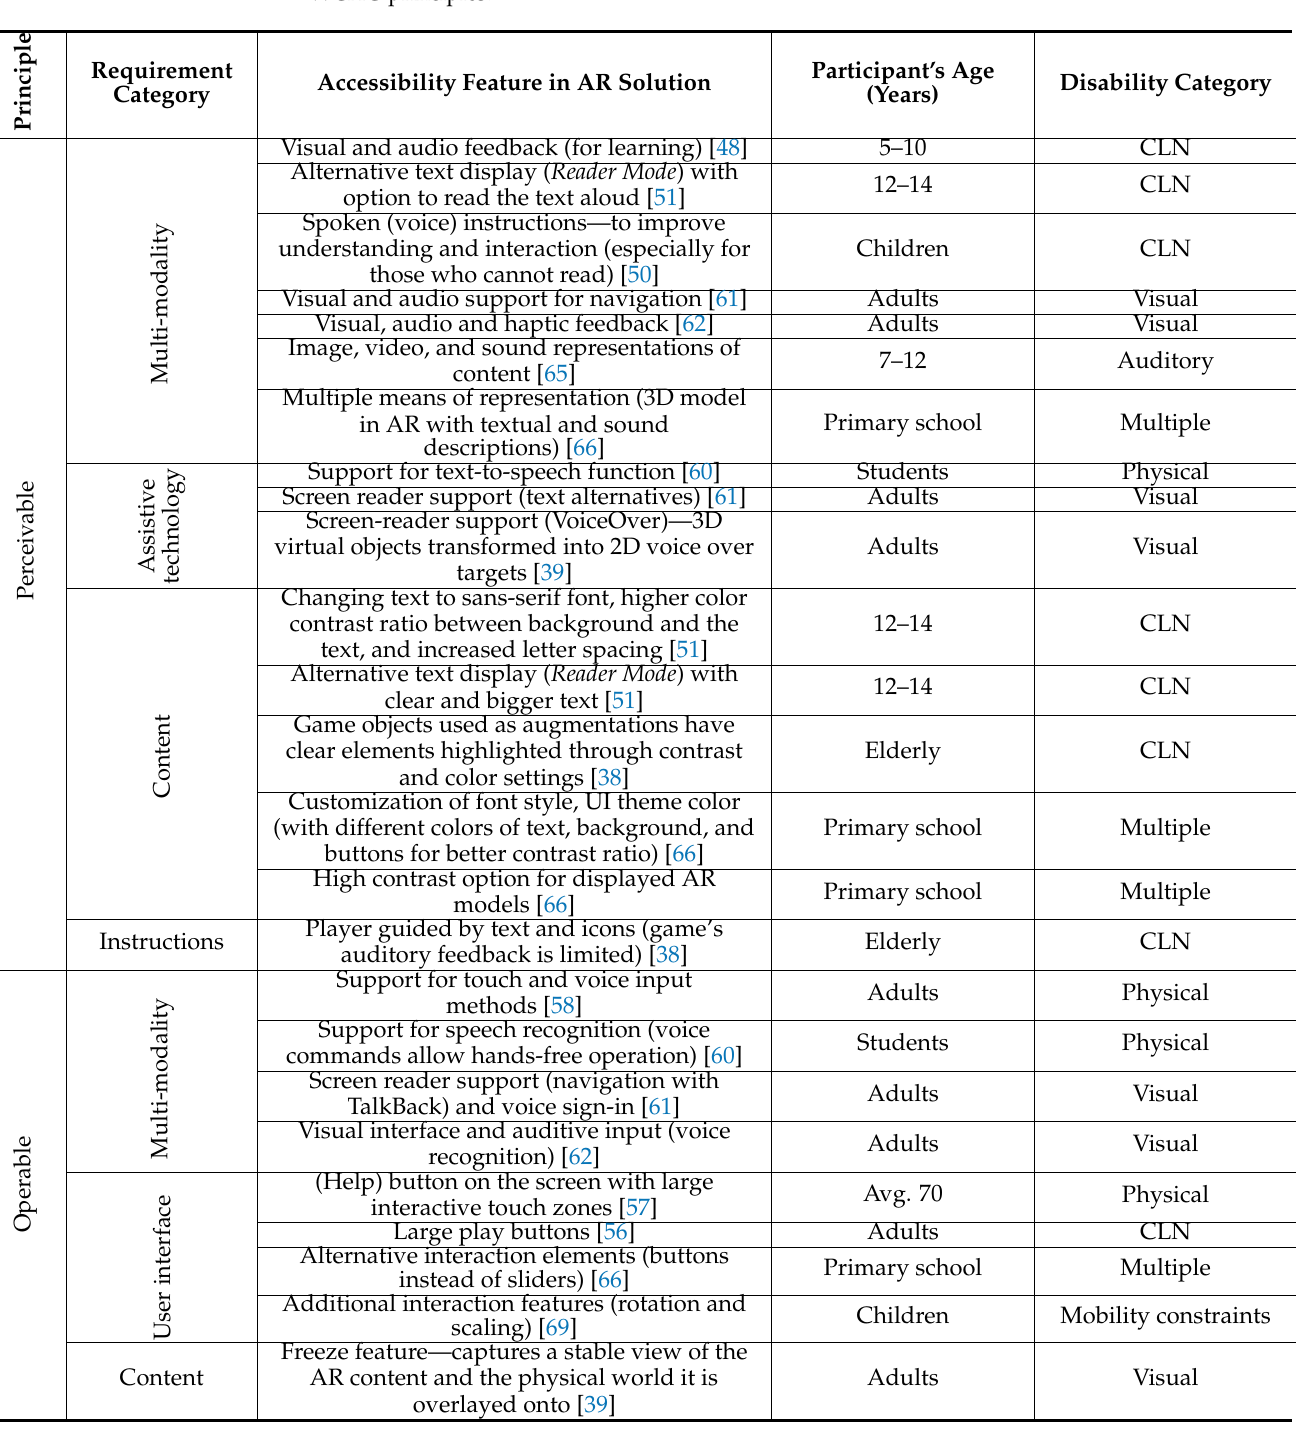
Table 4. Accessibility features implemented in AR solutions included in the review grouped by WCAG